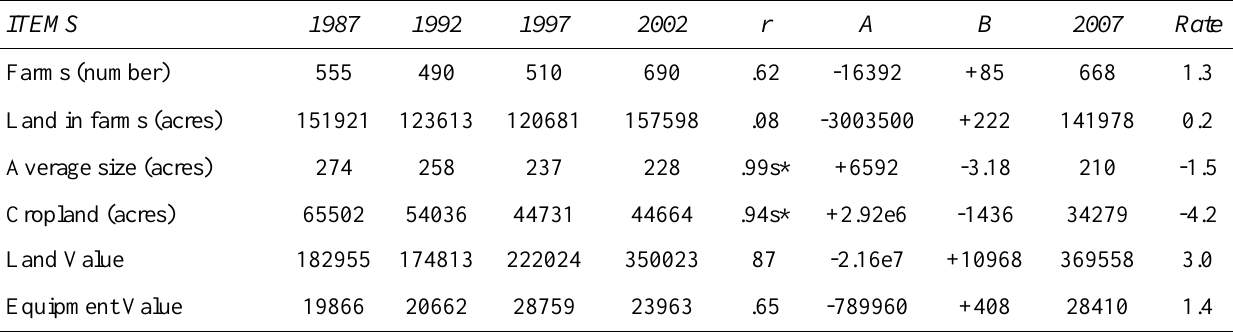
Table 2a: Copiah County Regression Analysis